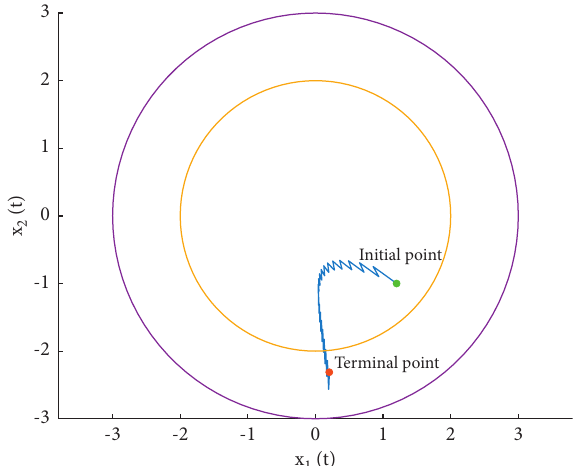
( t ) and x ( t ) of the impulsive linear control system equation (22) with 0 . 1s equidistant impulsive intervals. 1 2